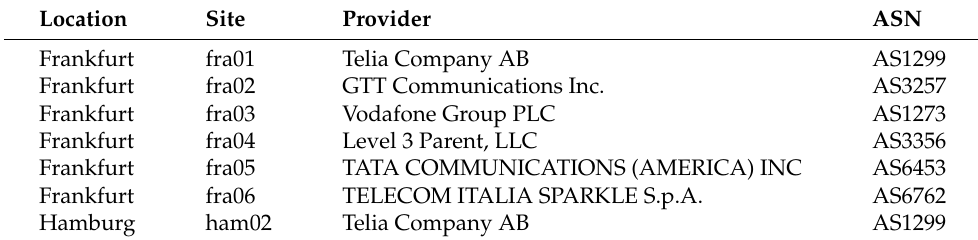
Table 2. MLab locations, sites and ASNs in